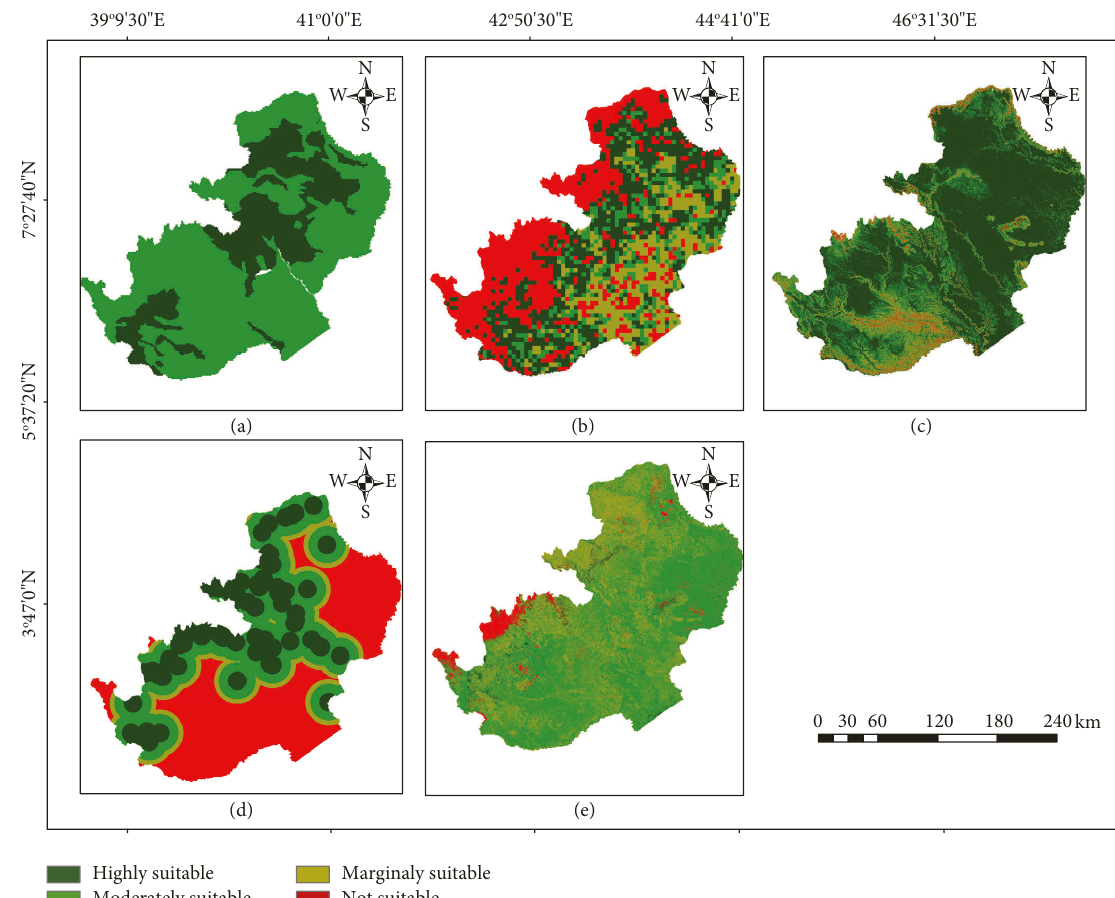
Figure 11: Factor suitability map for camel mobility: (a) soil type, (b) rainfall, (c) slope, (d) water accessibility, and (e) LULC.